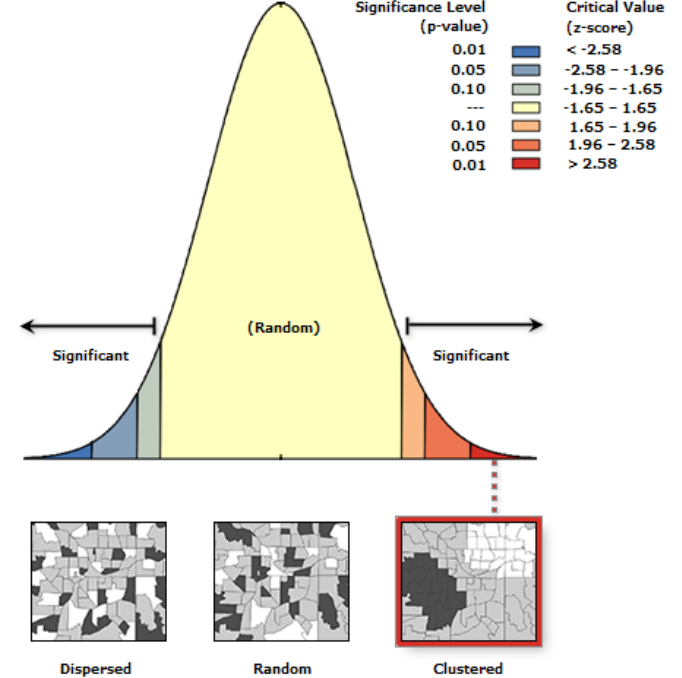
Figure 3. The analysis results of spatial autocorrelation of ICH in Shandong Province.